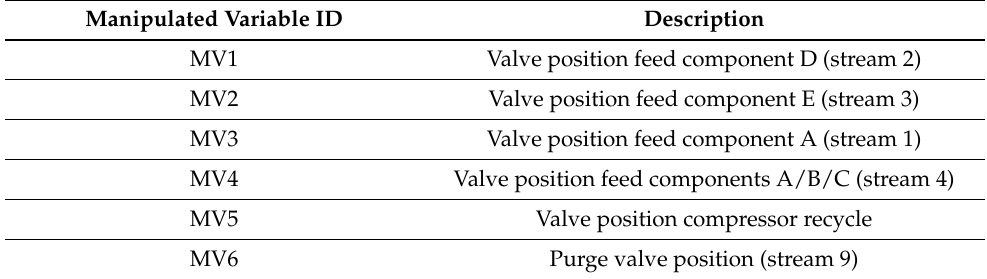
Table A2. Manipulated variables of